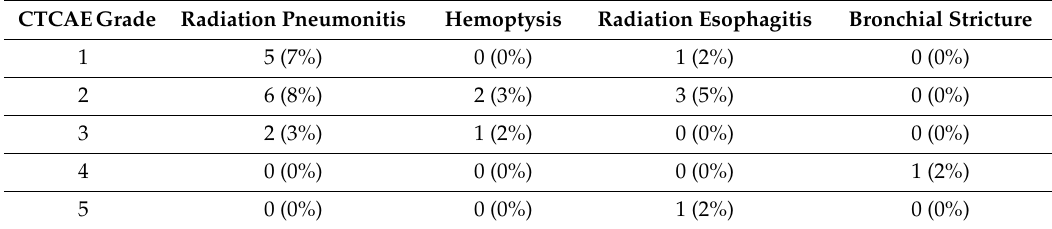
Table 2. Summary of toxicity. CTCAE: Common Terminology Criteria for Adverse Events. CTCAEGrade Radiation Pneumonitis